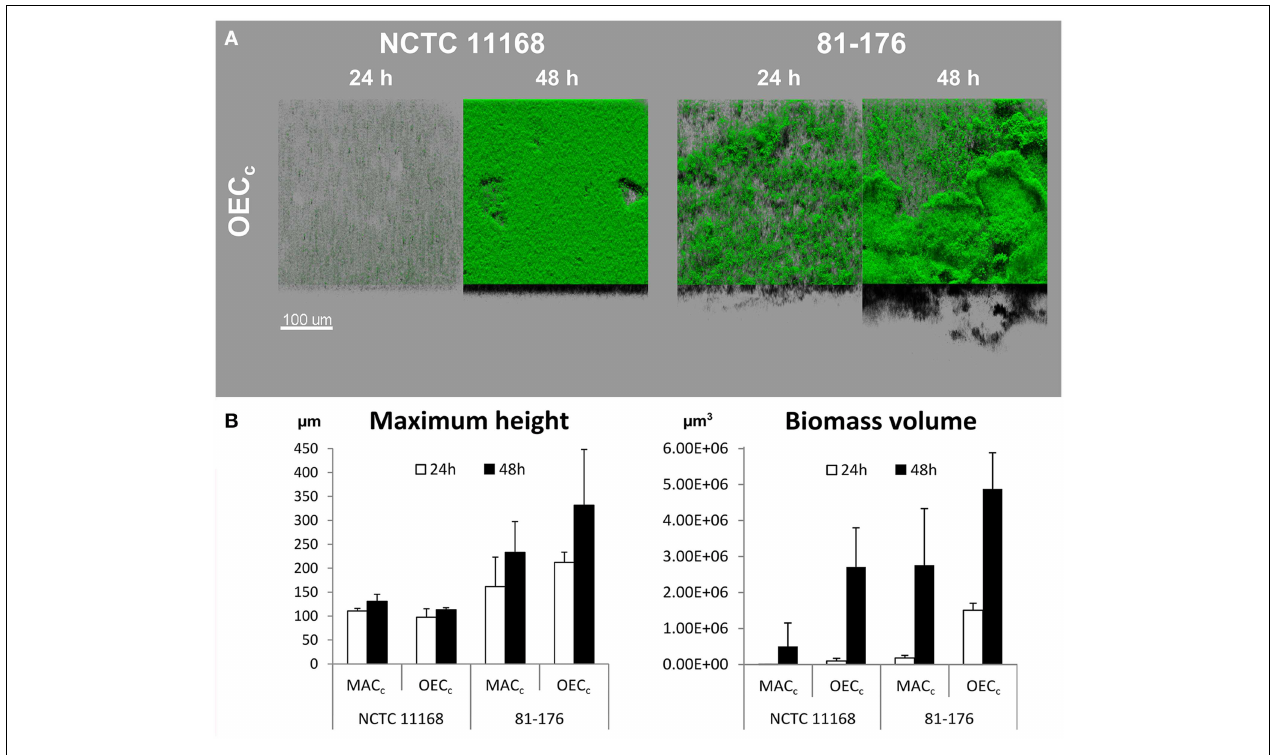
FIGURE 2 | Oxygen enhances biofilm development of C. jejuni NCTC 11168 and 81-176 after incubation for 24 and 48h. (A) The CLSM images represent an aerial view of the biofilm structures in OEC (19% O 2 , 10% CO 2 , 71% N 2 ) with the shadow projection at the bottom. (B) The effect